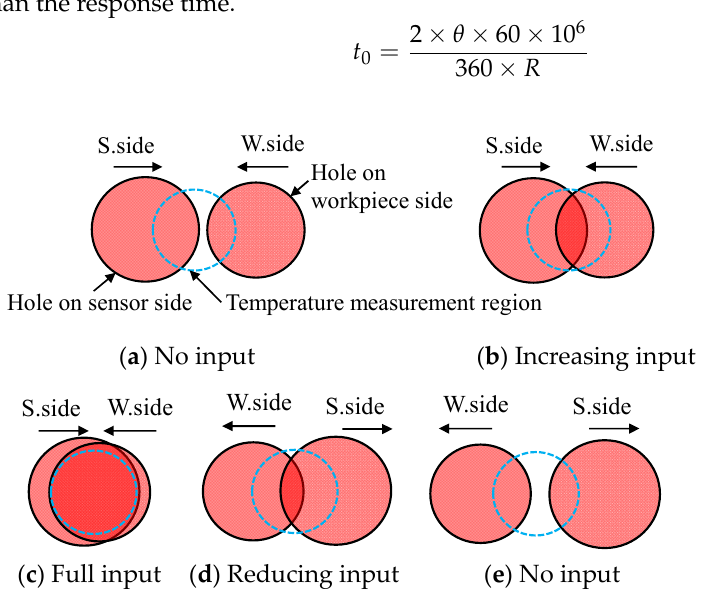
Figure 3. Transition of input to infrared sensor through two holes on the grinding wheel.